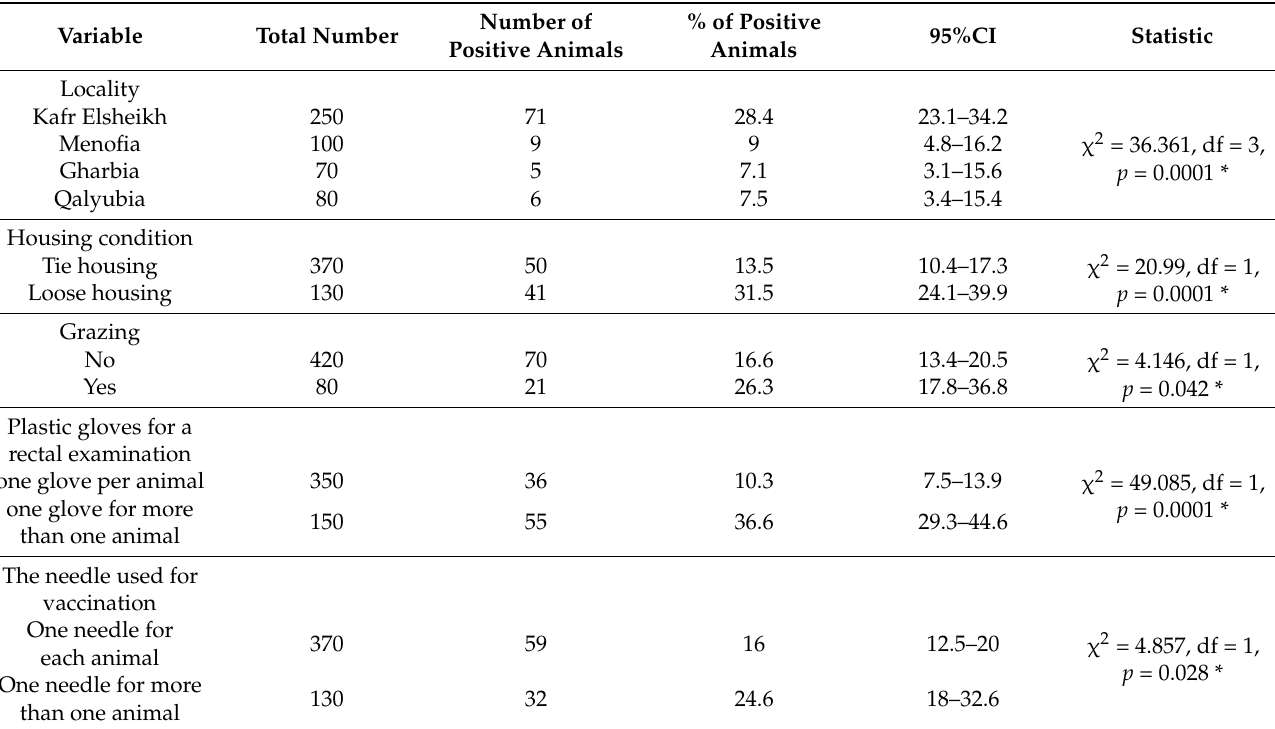
Table 1. Univariant logistic analysis for variables associated with seroprevalence of Bovine leukemia virus (BLV) infetion.